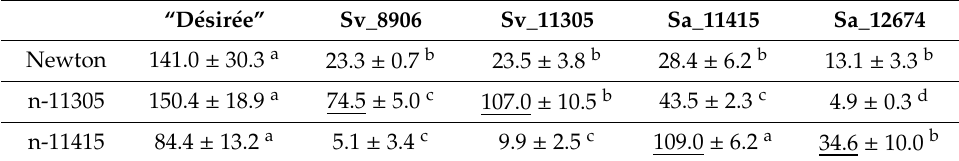
Table 1. The mean number of females of G. pallida Newton population and its associated selected populations on the root surface of cv. D é sir é e and Sv_8906, Sv_11305, Sa_11415 and Sa_12674. The experiment was repeated twice with four biological replicates per experiment. The underlined numbers show the mean number of females when the nematode populations were selected on the same resistance source as the tested potato line. The superscripted letters indicate the least significant di ff erence based on Tukey’s test ( p = 0.05) within each population along the di ff erent tested potato lines (i.e., di ff erent letters indicate values with statistically significant di ff erences). “D é sir é e” Sv_8906 Sv_11305 Sa_11415 Sa_12674 Newton 141.0 ± 30.3 a 23.3 ± 0.7 b 23.5 ± 3.8 b 28.4 ± 6.2 b 13.1 ± 3.3 b 150.4 ± 18.9 a 74.5 ± 5.0 c 107.0 ± 10.5